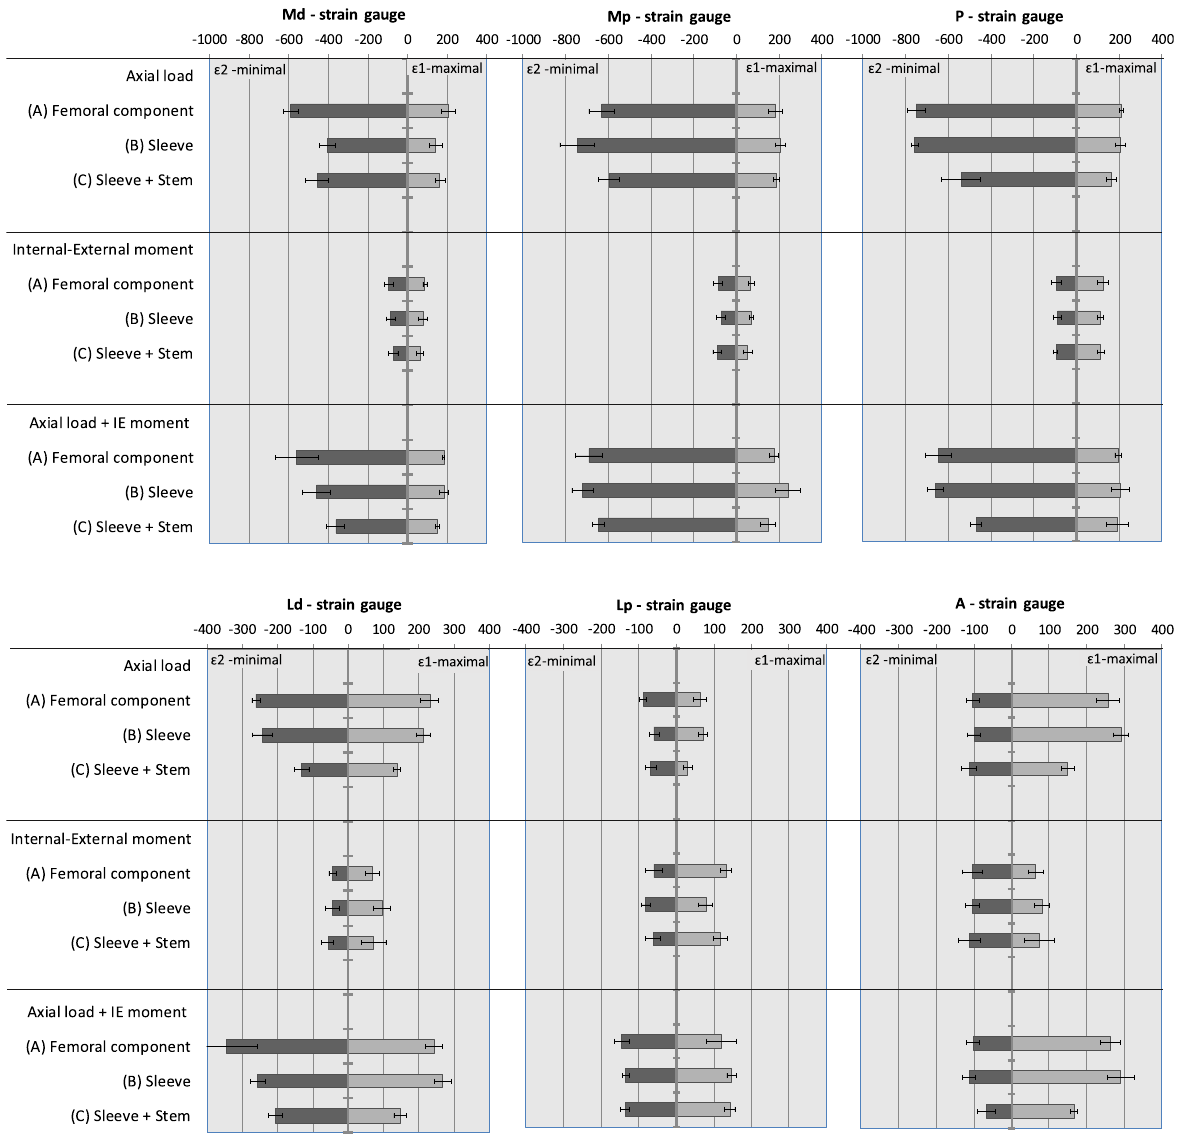
Fig. 4 Mean and standard deviation (error bars) of the measured principal strains ( ε 1 - maximal and ε 2 - minimal) at each strain gauge Md (medial distal), Mp (medial proximal), P (posterior), A (anterior), Ld (lateral distal) and Lp (lateral proximal) for each construct technique and load